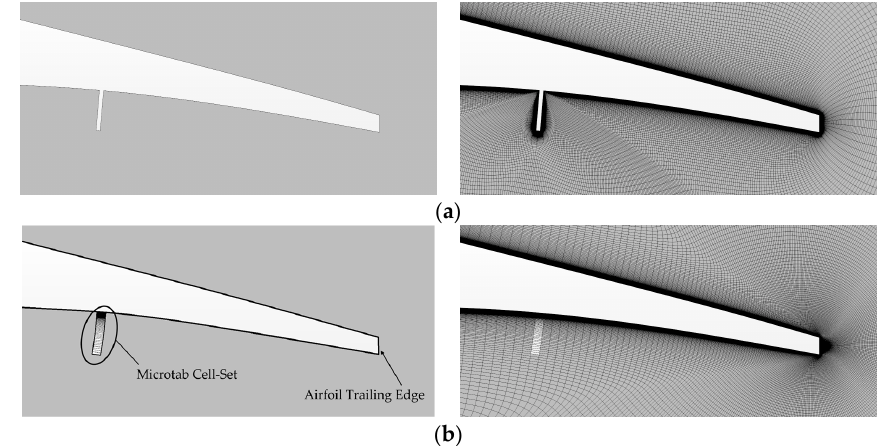
Figure 3. Comparison of the models for the generation of new geometries (microtabs): ( a ) fully-mesh model, DU91W(2)250_MTFM9310; ( b ) cell-set model, DU91W(2)250_MTCS9310. Snapshots show the mesh distribution around trailing edge area of the airfoil.